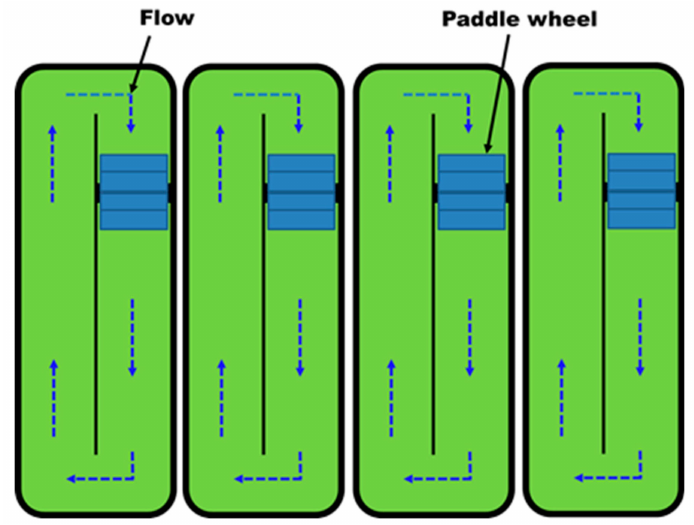
Figure 2. Schematic diagram showing simple open raceway pond with paddle wheel for gentle and uniform mixing of cells for outdoor